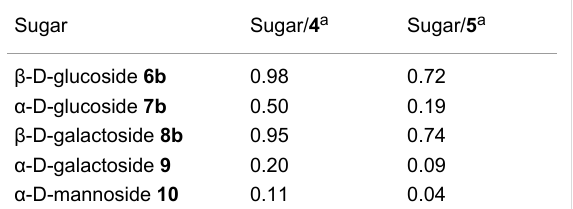
Table 1: Solubilization of sugars in CDCl 3 by receptor 4 and 5 (1 mM solution).